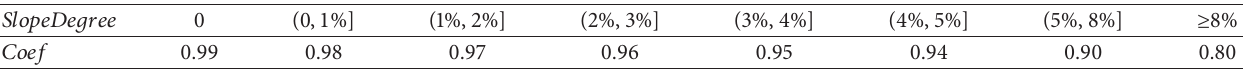
Table 3: The relationship between 𝑆𝑙𝑜𝑝𝑒𝐷𝑒𝑔𝑟𝑒𝑒 and 𝐶𝑜𝑒𝑓